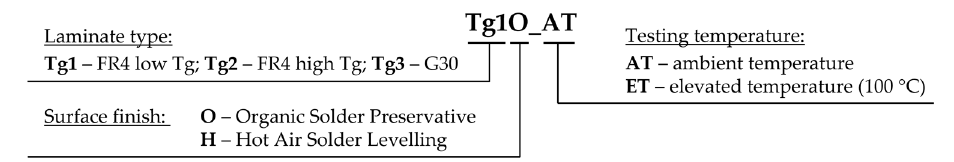
Figure 9. Explanation of the sample marking.